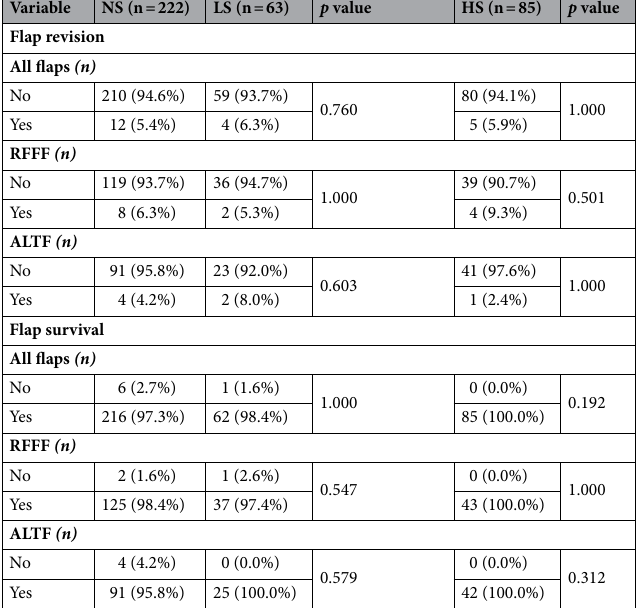
p = 0.035) for RFFFs and similar postoperative flap blood flow (70.5 AU vs. 71.0 AU; p = 0.856) for ALTFs com- pared with nonsmokers (Table 3, Fig. 2). For RFFFs and ALTFs, no differences were observed for postoperative hemoglobin concentration ( p = 0.946 and p = 0.749) and hemoglobin oxygen saturation ( p = 0.957 and p = 0.683) between heavy smokers and nonsmokers (Table 3). After adjusting for sex, age, BMI, diabetes, mean arterial blood pressure, and catecholamine dose, the dif- ference in intraoperative flap blood flow for ALTFs and postoperative flap blood flow for RFFFs between heavy smokers and nonsmokers persisted ( p = 0.006 and p = 0.046). Flap perfusion parameters described separately for 2 mm and 8 mm measurement depth, data for the regres- sions analysis including flap location, and data for testing differences between intraoperative and postoperative measurements of blood flow are added as supplementary data (Supplementary Table 1, 2 and 3).